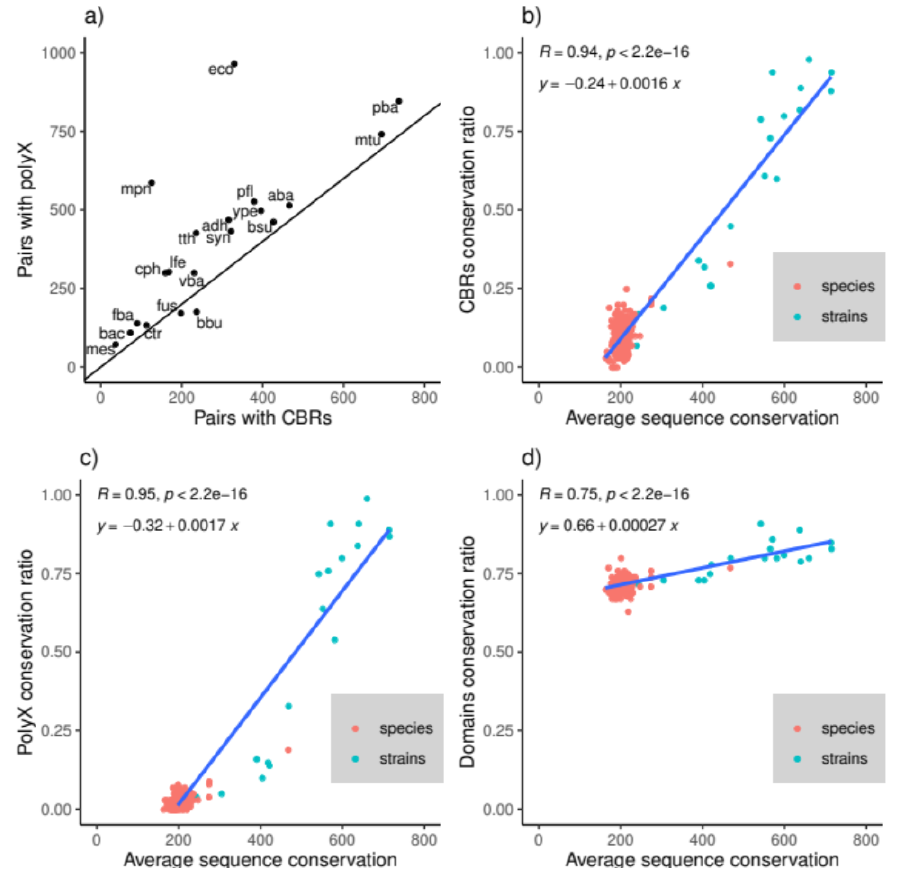
Figure 1. ( a ) Number of orthologous pairs between strains with polyX versus the number of pairs with compositionally biased regions (CBRs); in black, line x = y; ( b ) CBRs; ( c ) polyX, and ( d ) domain conservation ratio versus average full-sequence conservation in orthologs from pairs of strains (or species). Sequence conservation is measured as the average bit score of all orthologous pairs. The regression line is plotted in